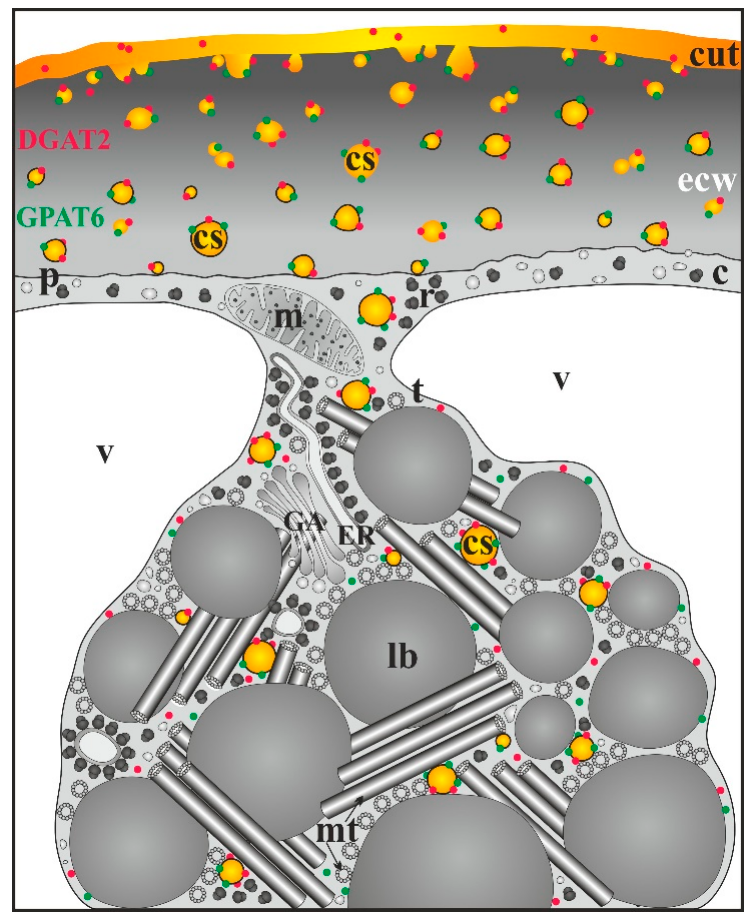
Figure 6. Cuticle formation of O. umbellatum ovary with cutinsome engagement and, additionally, with enzyme participation in cutin (GPAT6) and wax (DGAT2) synthesis. These enzymes are transported together with cutinsomes from LM, where their synthesis takes place, to the external cell wall and cuticle, which is their destination. The scheme is on the basis of TEM immunogold studies [30,44]; c, cytoplasm; cs, cutinsome bordered with a shell (black ring) and without it; cut, cuticle; ecw, external cell wall; ER, endoplasmic reticulum; GA, Golgi apparatus; lb, lipid body; m, mitochondrion; mt, microtubules; p, plasmalemma; r, ribosome; t, tonoplast; v, vacuole.